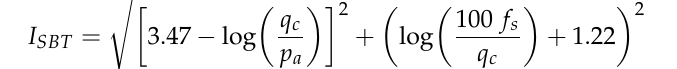
Figure 4. The values of ISBT in the selected homogeneous layer (4–8 m below the surface) for CPTs from Ś wierzna [42] presented in Robertson’s classification [44]. Using a similar procedure for the case of Keswick clay, a homogeneous layer between 3.0 and 5.0 m below the surface was found and selected for further analysis. The results of q c , f s , and I SBT for the considered tests are shown in Figure 5. This time the q c values ranged from 1.23 to 2.51 MPa with the mean value of 190 MPa, and f s values ranged from 0.07 to 0.19 MPa with the mean value of 0.13 MPa. Figure 6 presents the results from the selected layer in Robertson’s classification [44].